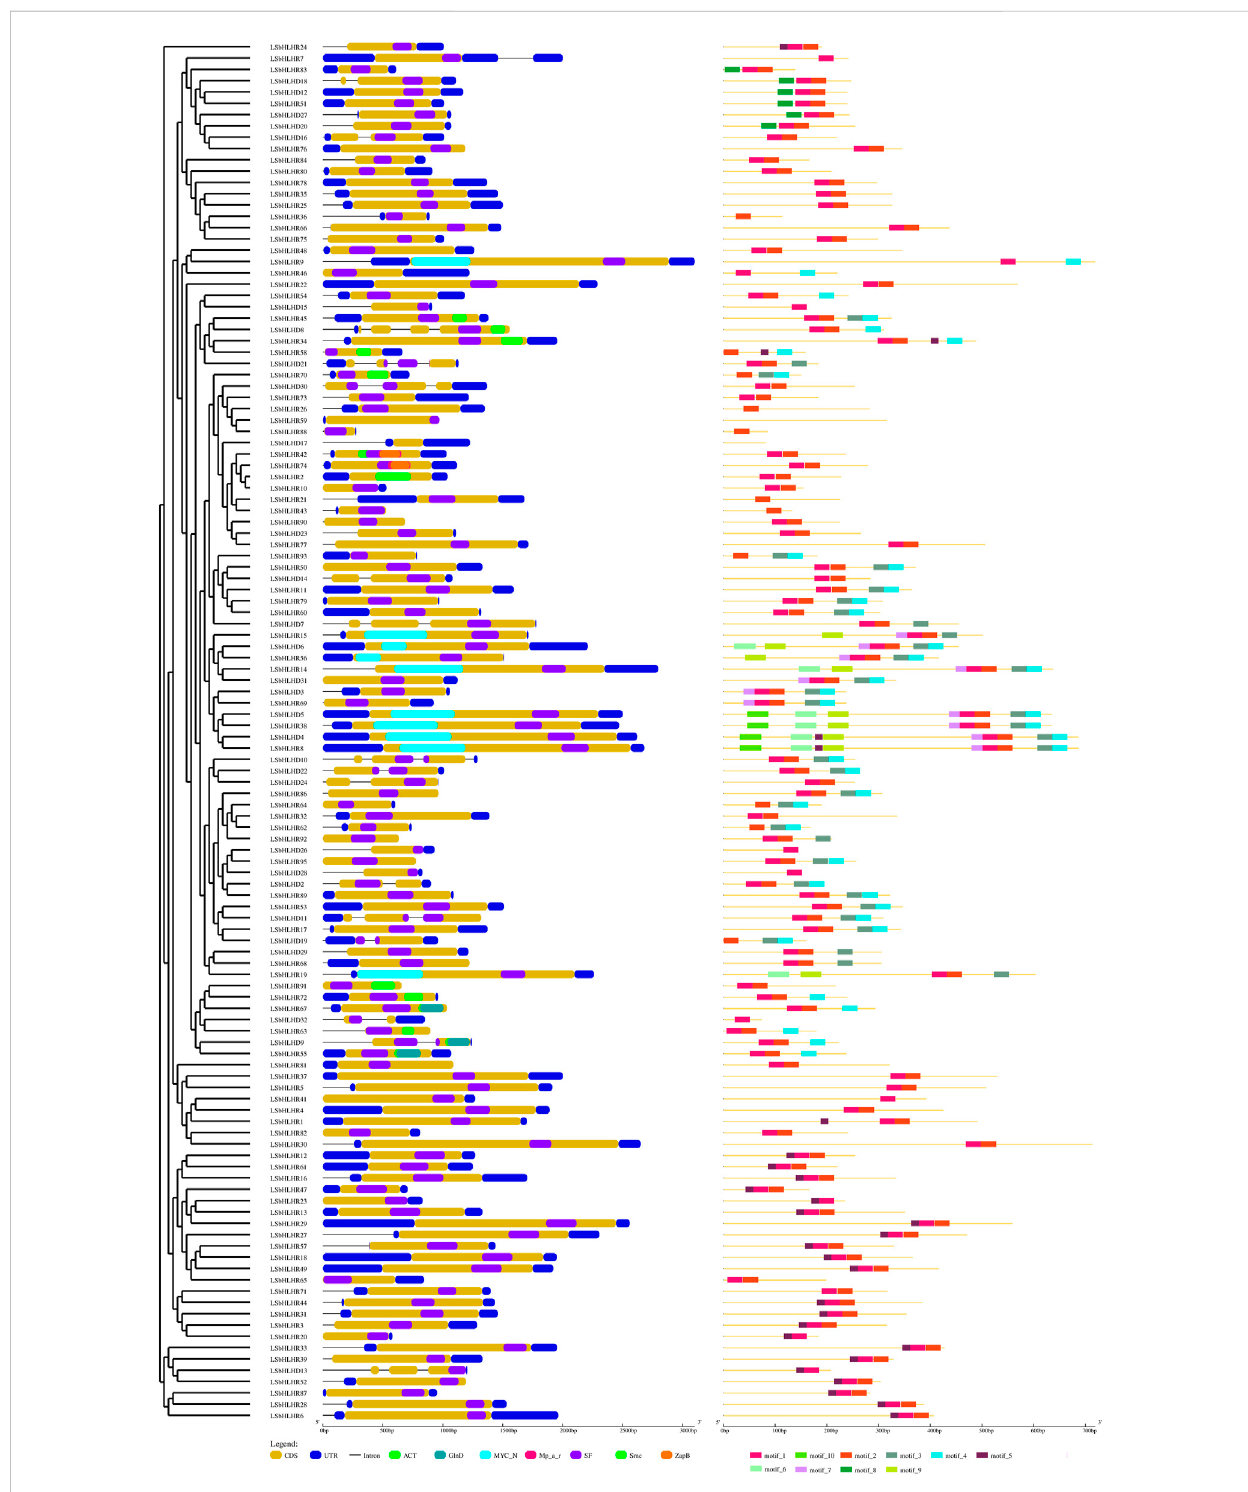
FIGURE 3 The genestructure, conserved motifs,and phylogeneticrelationships ofLsbHLH genes fromgrass pea.A phylogenetic tree of122LsbHLH proteins, their exon-intron organization, and transcription factor (TF) domains retrieved from NCBI-CDD are presented. Additionally, the arrangement of ten conserved motifs in the LsbHLH proteins is depicted, each represented by a different color